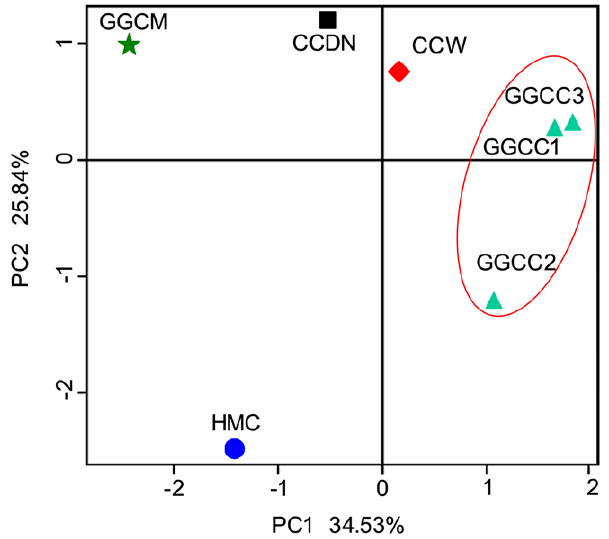
Figure 5. Sample Sorting analysis. Scatterplot of PCA-score depicting variance of fingerprints derived from different bacterial community. Principal components (PCs) 1 and 2 explained 34.53% and 25.84% of the variance, respectively.